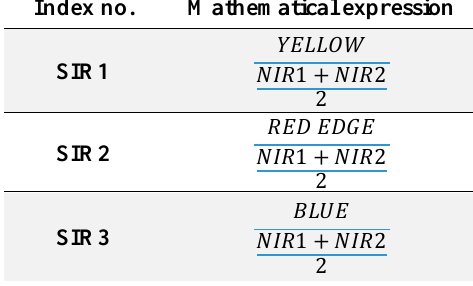
Table 3. The devised customized spectral index